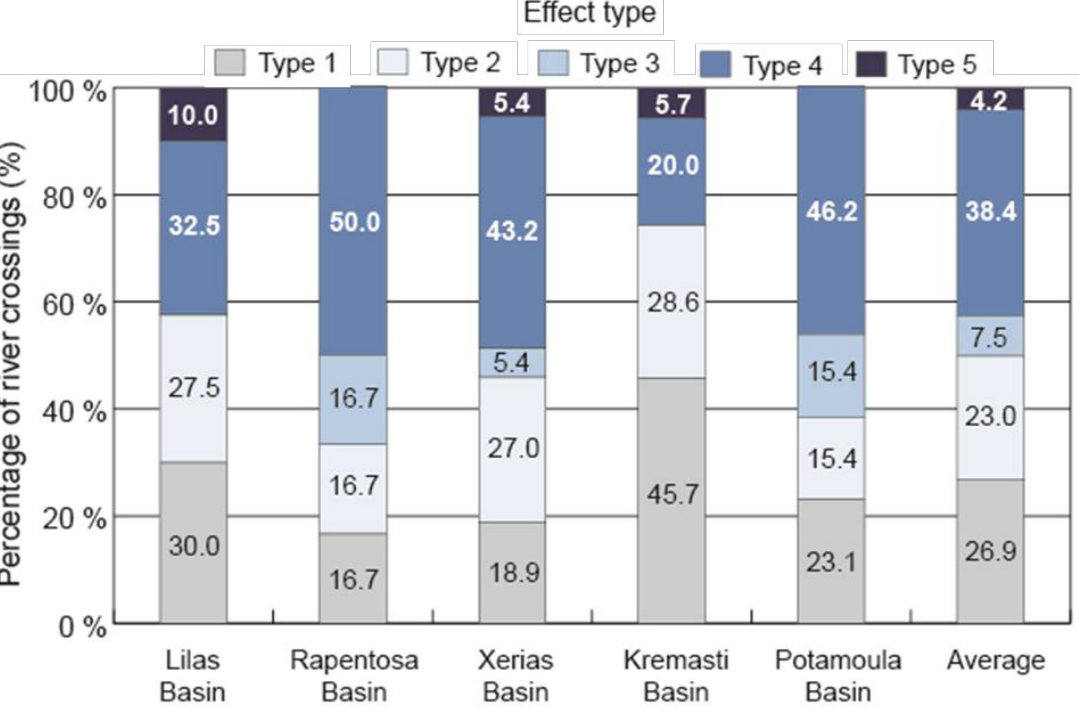
Figure 7. Percentages of effect type per examined basin The type of damage appeared to be related with the type of infrastructure (Figure 8). Out of 38 cases of “low water crossings”, 86.8% were inundated, 42.1% experienced damages and 7.9% suffered non-restorable damages or collapsed. Out of 87 cases of single-span bridges, 65.5% were inundated, 36.8% were damaged and 5.7% suffered non-restorable damages or collapsed. In 6 cases of multi-span bridges, 33% were flooded and damaged, but none of them collapsed or suffered critical damage. Low water crossings were found to be more vulnerable to inundation and to damages from extreme precipitation events and subsequent flash flooding, as only 13.2% of them were not affected (Figure 8). On the contrary, multi-span bridges presented less vulnerability than the other two types, with 66.7% not suffering any effect from flooding. This difference can probably be attributed to the larger cross sectional